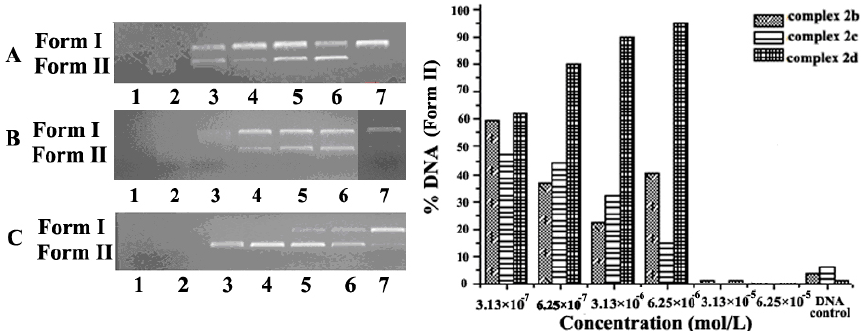
Figure 2. Histograms and electropherograms (the right side figure) representing cleavage of pUC19 plasmid DNA (0.008 µg/µL) by different concentrations of 2b (pH = 7.4), 2c (pH = 7.4) and 2d (pH = 7.4) in buffer (5 mM Tris-HCl/10 mM NaCl) at 37°C for 6 h. ( A ) Complex 2b ; Lanes 1–6: 6.25 × 10 − 5 , 3.13 × 10 − 5 , 6.25 × 10 − 6 , 3.13 × 10 − 6 , 6.25 × 10 − 7 , 3.13 × 10 − 7 mol/L, Lane 7 = DNA control, respectively; ( B ) Complex 2c; Lanes 1–6: 6.25 × 10 − 5 , 3.13 × 10 − 5 , 6.25 × 10 − 6 , 3.13 × 10 − 6 , 6.25 × 10 − 7 , 3.13 × 10 − 7 mol/L, Lane 7 = DNA control, respectively; ( C ) Complex 2d ; Lanes 1–6: 6.25 × 10 − 5 , 3.13 × 10 − 5 , 6.25 × 10 − 6 , 3.13 × 10 − 6 , 6.25 × 10 − 7 , 3.13 × 10 − 7 mol/L, Lane 7 = DNA control, respectively.